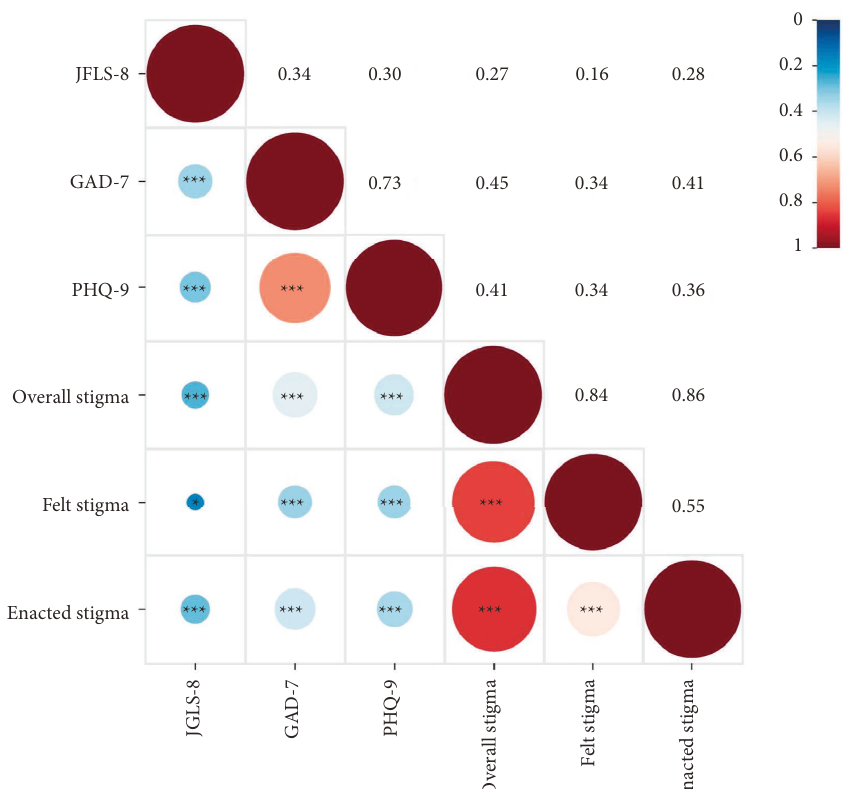
Figure 1: The heatmap of correlations among the study variables. Spearman’s correlation analysis is used. ∗ P value < 0.05; ∗∗∗ P value <